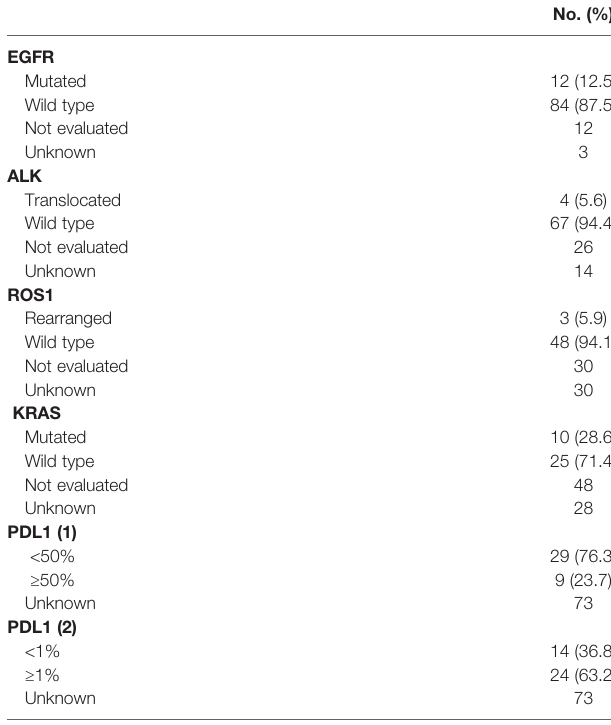
EGFR, epidermal growth factor receptor; ALK, anaplastic lymphoma kinase; ROS1, c-ros oncogene 1; KRAS, Kirsten rat sarcoma viral oncogene homolog; PDL1, programmed death-ligand